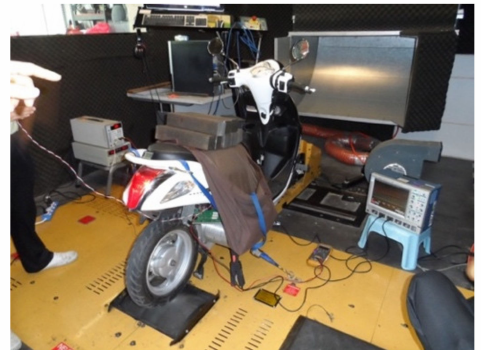
Figure 19. Test run of the constructed electric motorcycle on a chassis